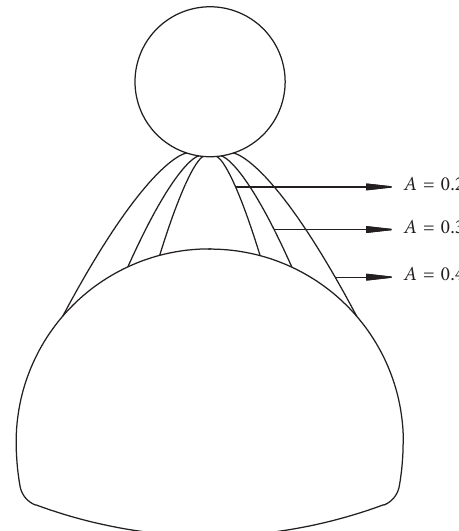
Figure 4: The shape and range of the collapse surface for different values of A .